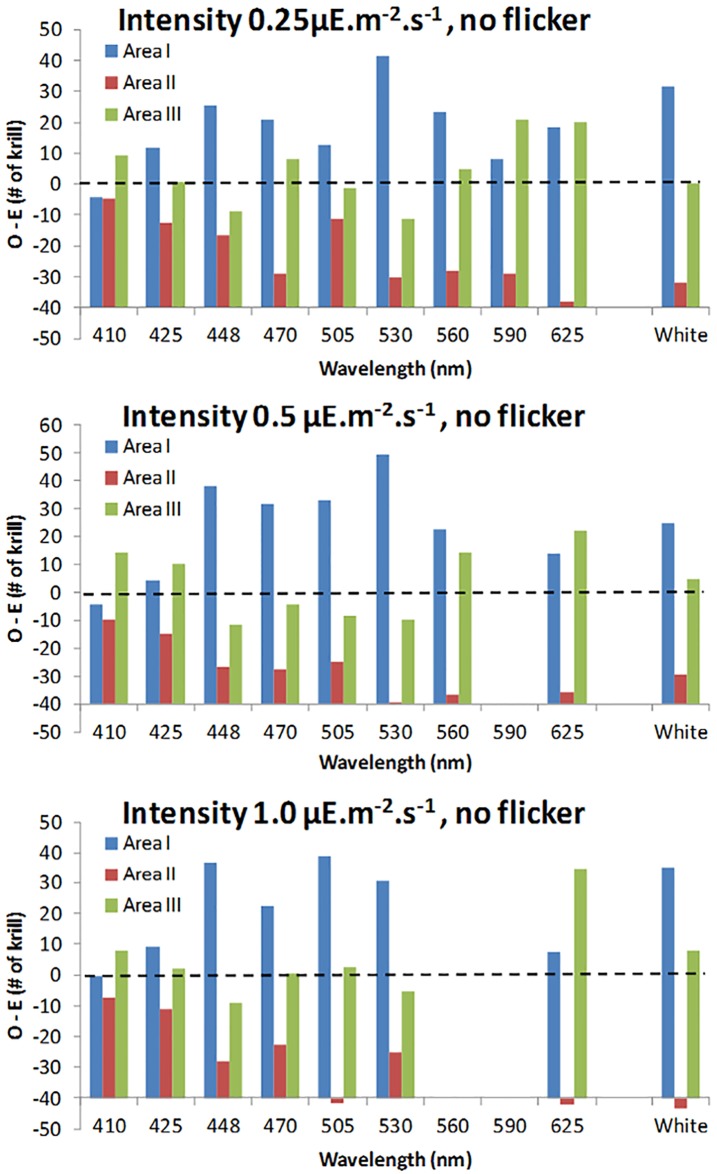
Difference between observed and expected (random) distribution of krill, when testing the effect of light intensity and wavelength.The difference between the observed and expected (i.e. when assuming a random distribution, --- line) numbers of krill in each area of the observation tank when exposed to different wavelengths (see Fig 2A) and intensities. Area I is closest to the light source, while area III is furthest away (see Fig 1B).